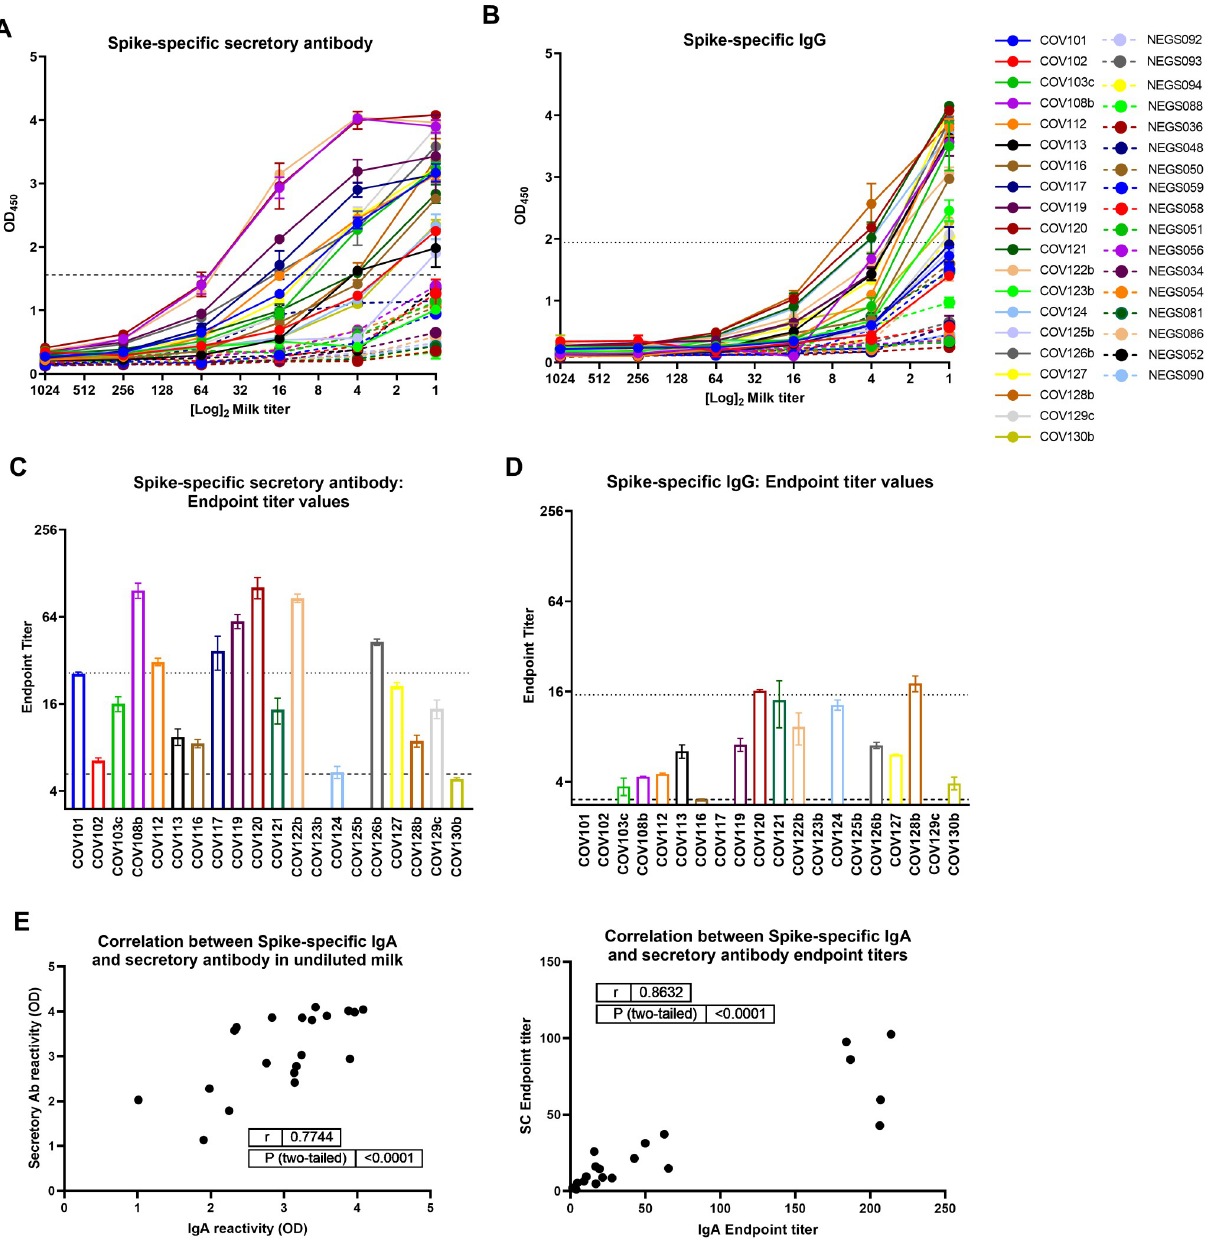
Fig 2. The dominant Spike-specific IgA response in milk after SARS-CoV-2 infection is strongly correlated with a robust secretory Ab response, while specific IgG activity is relatively modest. Twenty samples assayed for Spike-specific IgA were also assessed for Spike-specific secretory Ab (by detecting for SC), and IgG. (A, B) Full titration against Spike, detecting (A) secretory Ab, and (B) IgG. NEG (i.e. negative)/segmented lines: pre-pandemic controls. COV/solid lines: milk from COVID-19-recovered donors. Dotted lines: positive cutoff values. (C, D) Endpoint titer values calculated for (A) secretory Ab, and (B) IgG. Segmented lines: positive cutoff values; dotted lines: 5x positive cutoff (high-titer cutoff). (E) IgA and secretory Ab binding OD values or endpoint titers were used in 2-tailed Spearman correlation tests. SC: secretory component.